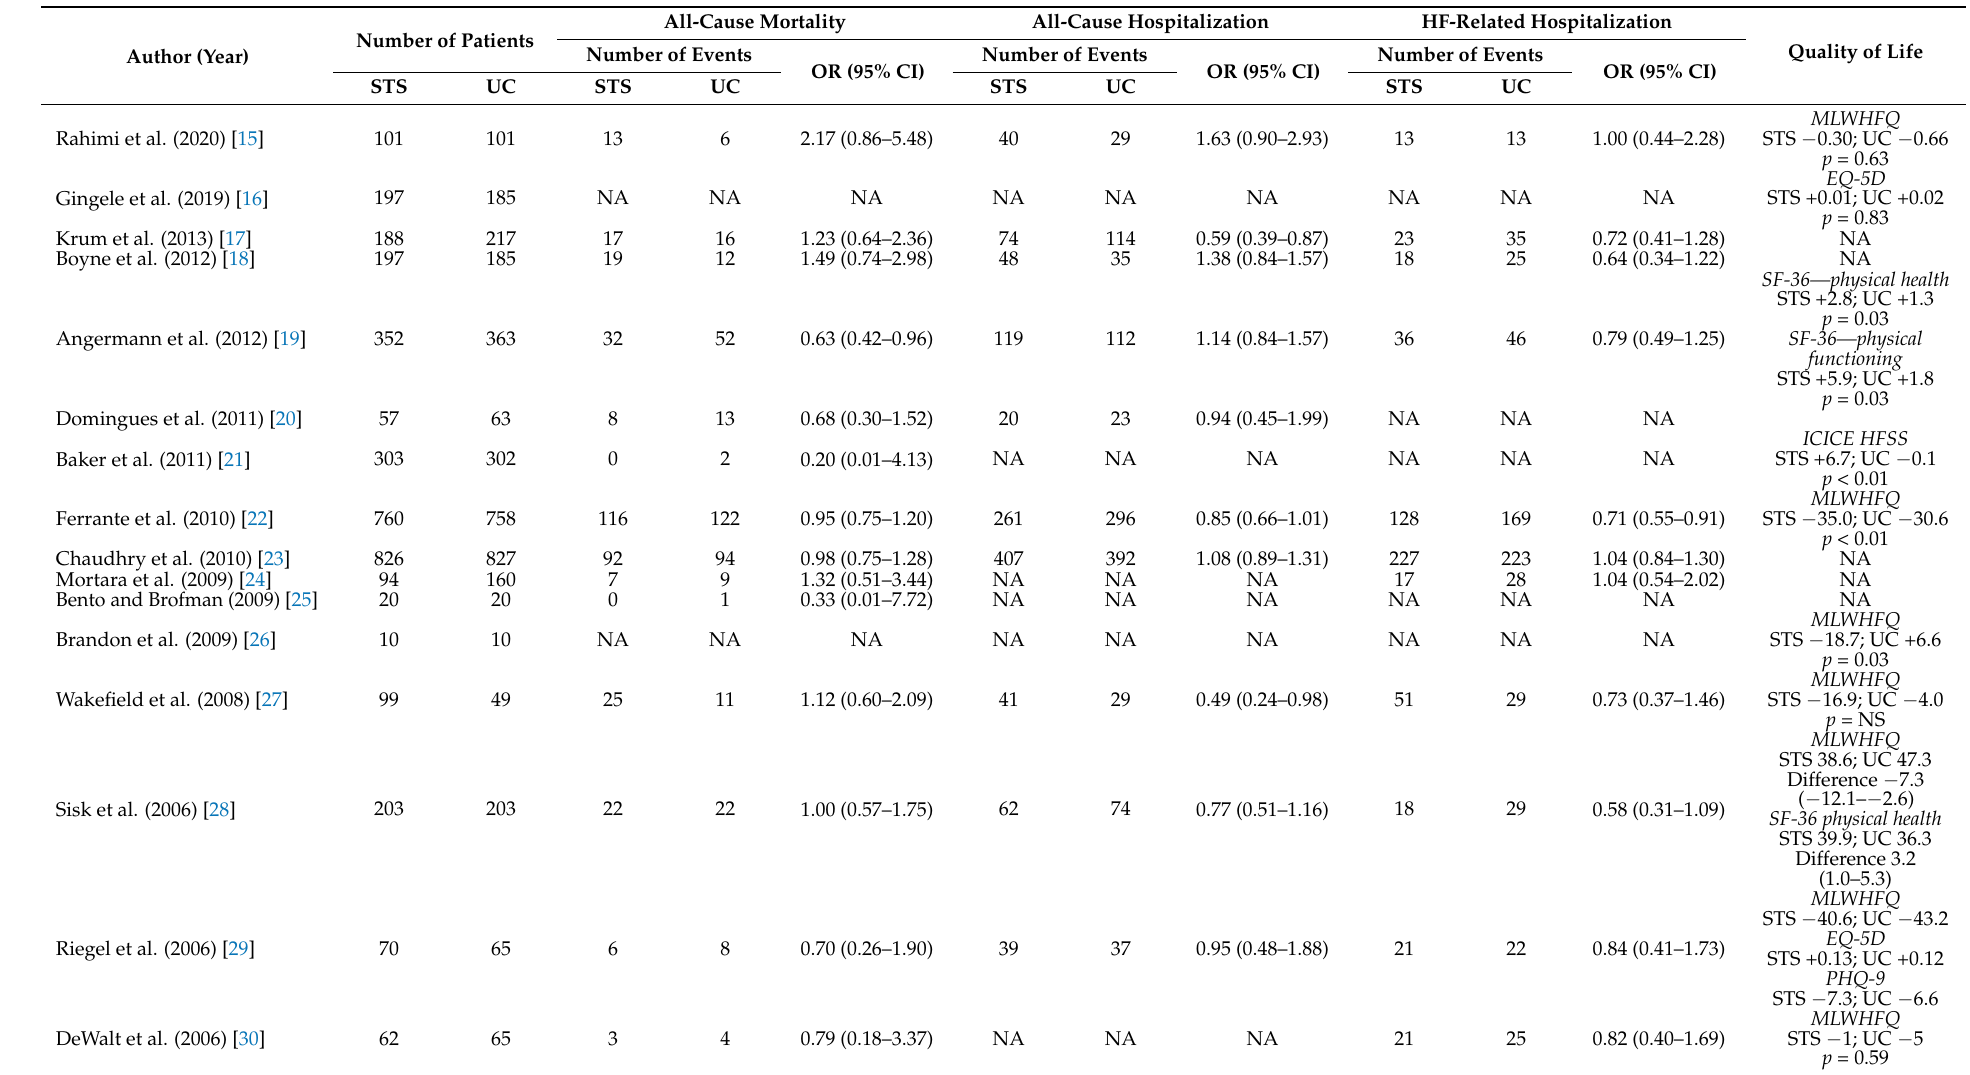
Table 2. Clinical outcomes of structured telephone support